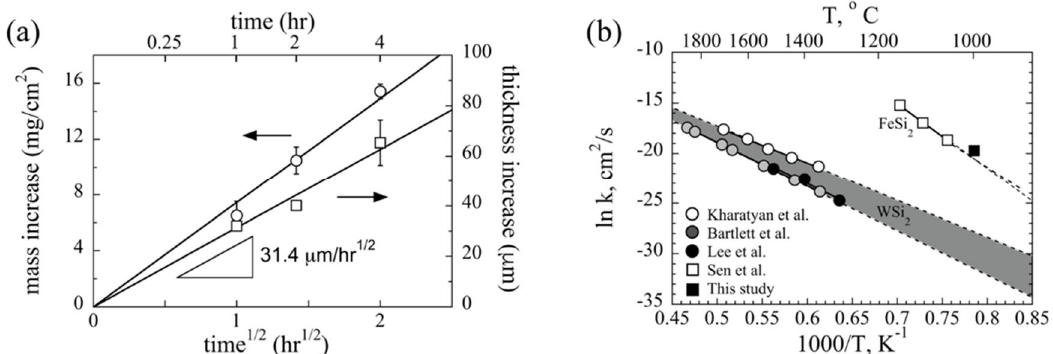
Figure 4. Kinetics of coating formation. ( a ) Parabolic growth kinetics. Error bars show standard deviation between three nominally identical samples. ( b ) Arrhenius plot comparing growth kinetics to literature growth rates of WSi 2 (circles) and FeSi 2 (squares) [27–31].